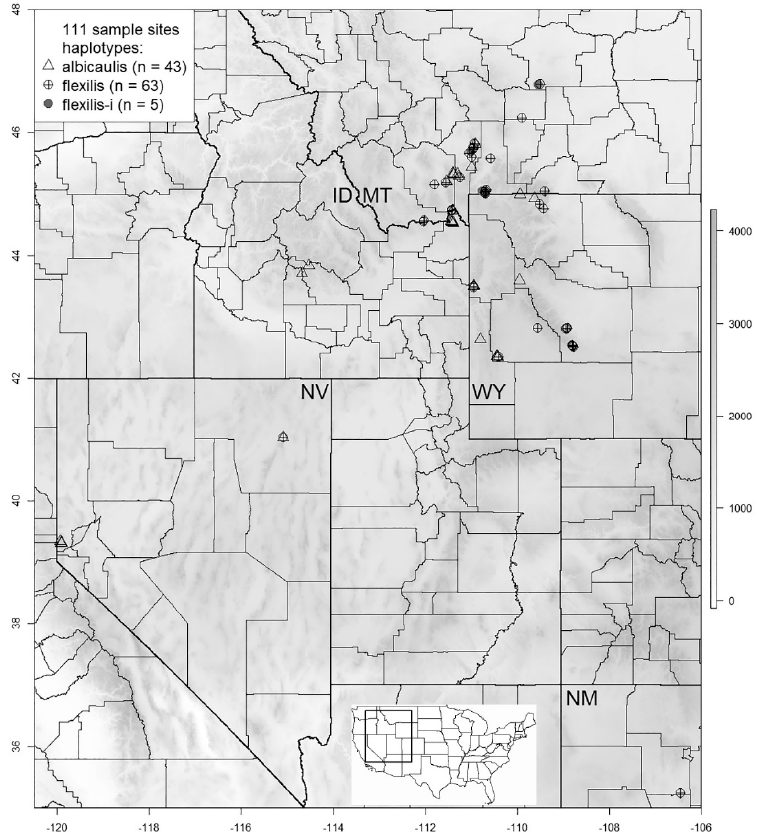
Figure 4. Geographic distribution in Idaho (ID), Montana (MT), Nevada (NV), New Mexico (NM), and Wyoming (WY) of the 111 sites where we sampled trees with attached seed cones. The rectangle on the inset map of the USA provides a larger geographical context of sample sites. Symbols marking each site indicate the sampled psbA - trnH haplotype. The shading represents elevation (m). Overlapping cross-circles and open triangles indicate where limber and whitebark pine are sympatric (e.g., Madison County, Montana; Elko County, Nevada; and Teton County, Wyoming).